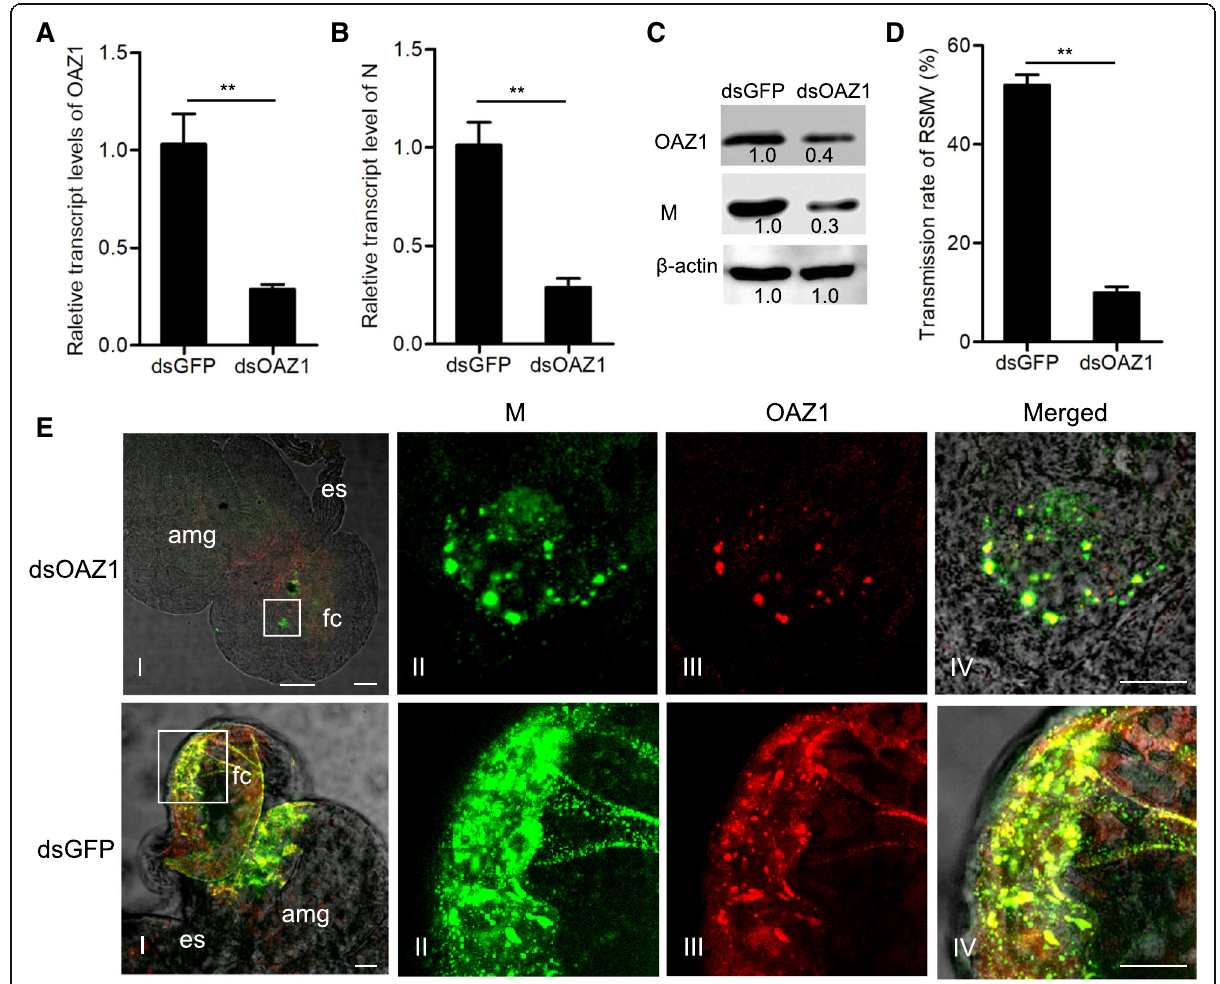
Fig. 4 Knockdown of OAZ1 expression inhibited viral infection and transmission by R. dorsalis . A, B The transcript levels of OAZ1 ( A ) and M ( B ) in viruliferous insects after treatment of dsGFP or dsOAZ1 were measured by RT-qPCR assay. C The protein levels of OAZ1 and M in viruliferous insects after treatment of dsGFP or dsOAZ1 were detected by western blot assay using OAZ1- and M-specific IgGs. Insect β -actin was detected with β -actin-specific IgG as an internal control. D Transmission rates of RSMV by dsGFP- or dsOAZ1-treated R. dorsalis individuals. E The intestines of viruliferous insects after treatment of dsOAZ1 or dsGFP were immunolabeled with M-FITC (green) and OAZ1-rhodamine (red) at 4 days padp. es, esophagus; fc, filter chamber; amg, anterior midgut. Panels II-IV are the enlargements of the boxed areas in panels I. Bars, 30 μ m. Data in A , B and D are presented as means (± standard deviation) from three independent experiments (Student ’ s t -test, two tailed). **, P <